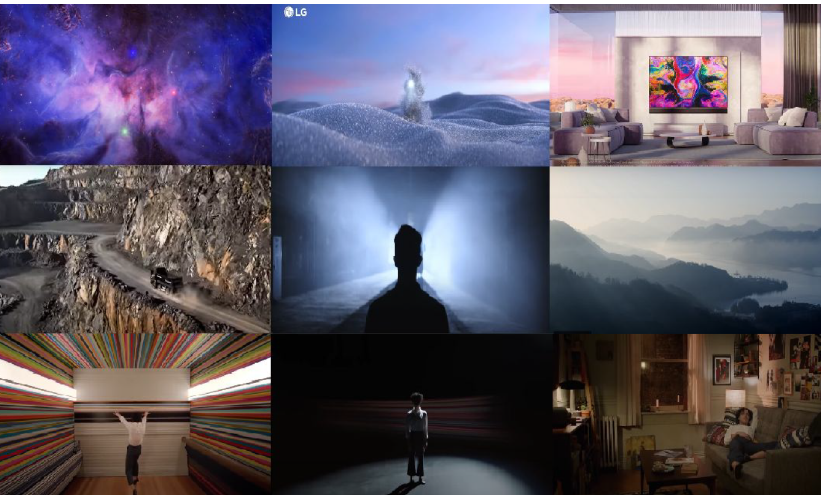
Figure 3. Dataset of emotionally appealing advertisements for domain